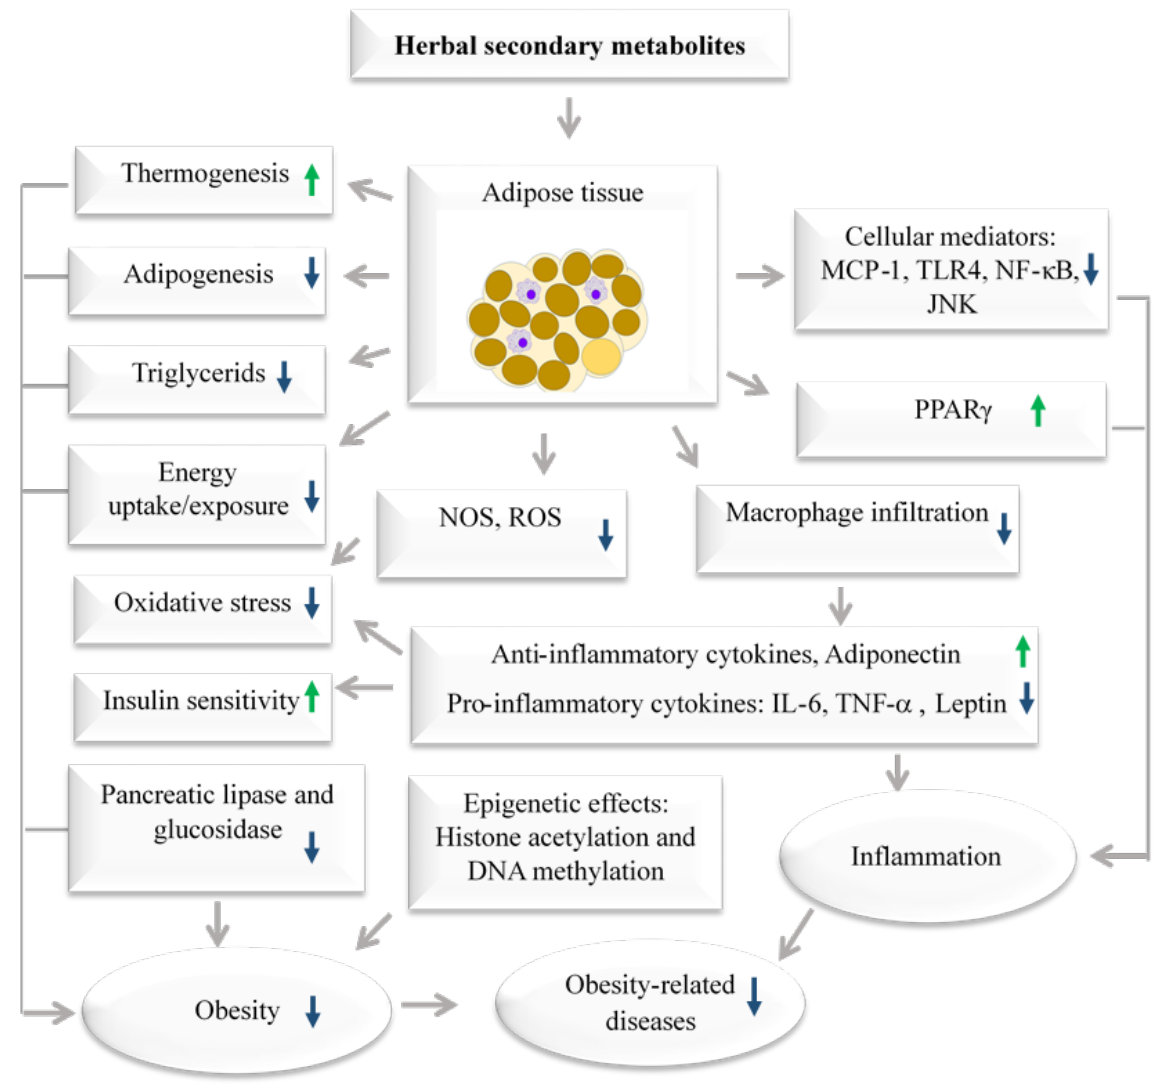
Figure 1. Management of overweight and obesity by medicinal plants, diet, and natural